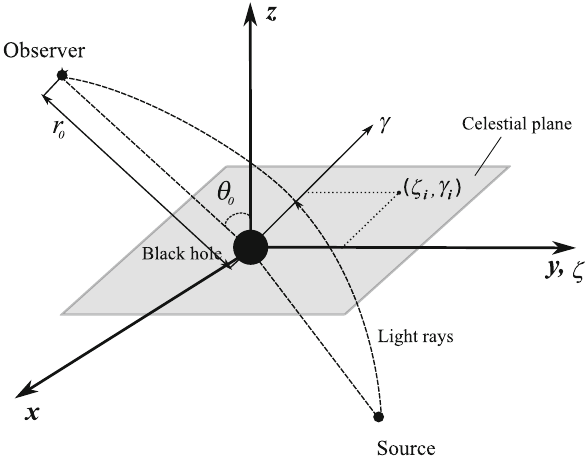
Fig. 1 Demonstration of celestial coordinates